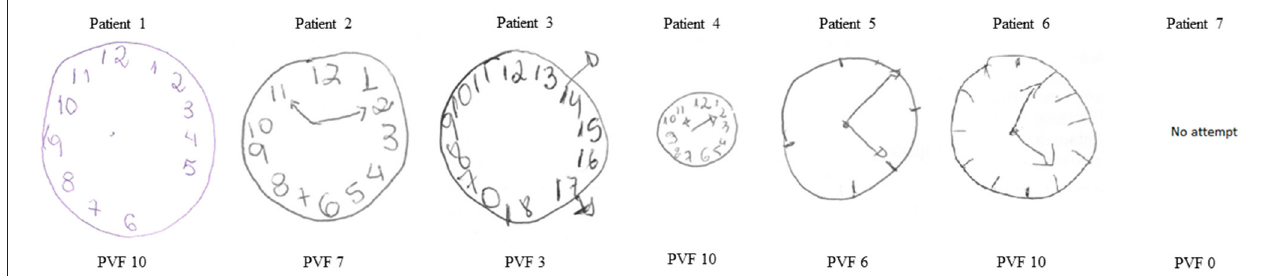
FIGURE 2 | Clock drowing test and phnemic verval fluency from patients with neurological symptoms associated with COVID-19. PVF, phonemic verbal fluney. PVF cut off ≥ 11 words in a